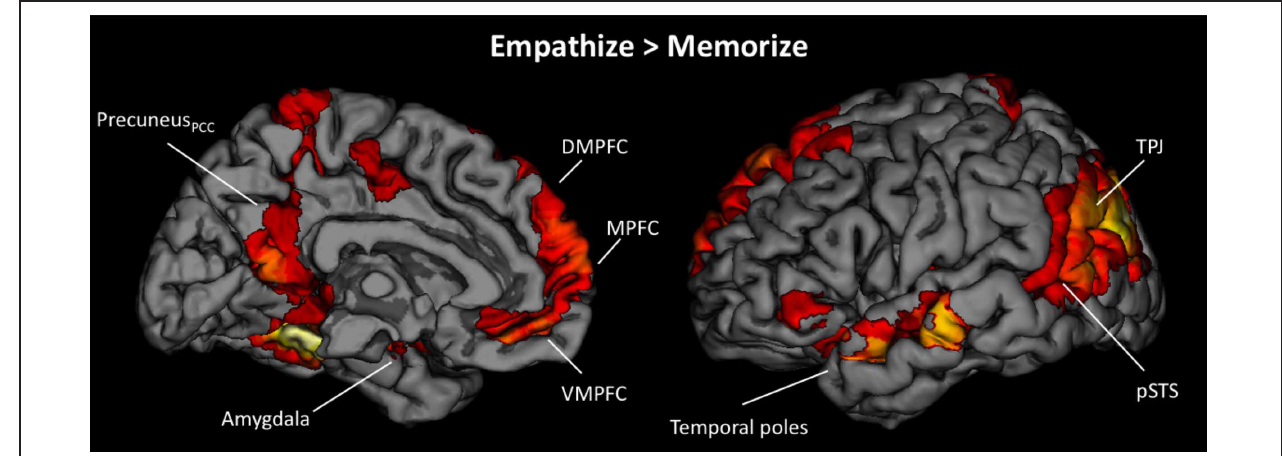
FIGURE 5 | Neural regions that showed reduced activity under cognitive load compared to empathizing (Empathize > Memorize).